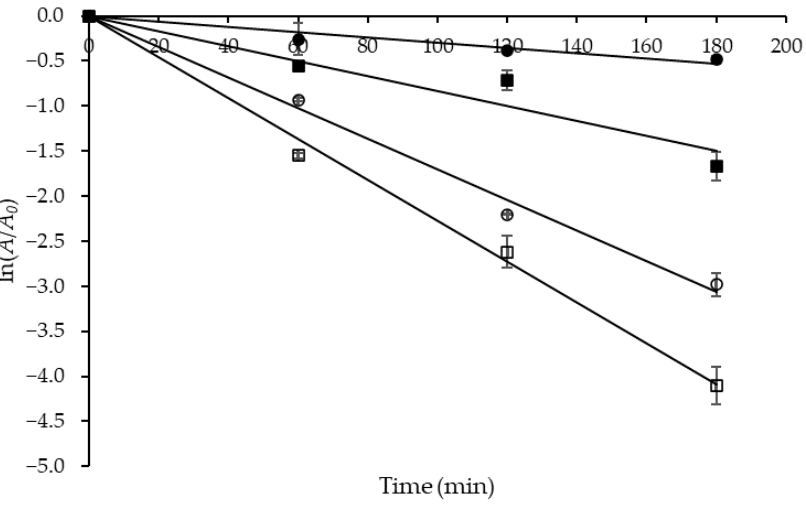
Figure 4. Semi-log plots of the coefficient of residual activity (A/A 0 ) of Aspergillus tamarii URM4634 protease versus time used to estimate the first-order inactivation rate constant (k d ) at different temperatures ( ◦ C): ( • ) 50; ( (cid:4) ) 60; ( (cid:13) ) 70; ( (cid:3) ) 80. Table 6. Kinetic and thermodynamic parameters of thermal denaturation of crude Aspergillus tamarii URM4634 protease produced by sequential fermentation using wheat bran as a substate.